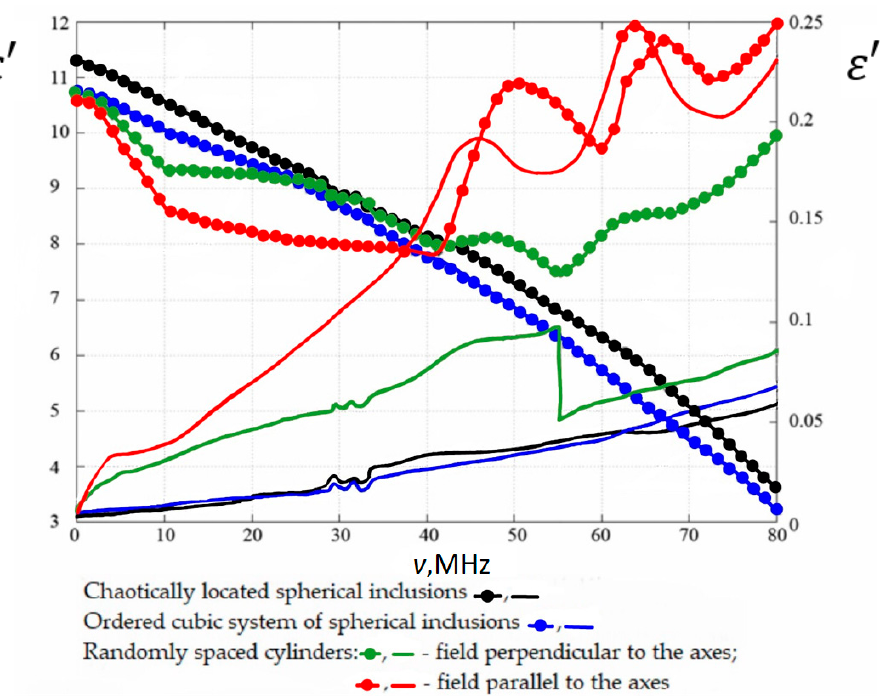
Figure 5. Frequency dependences of the complex permittivity for cylindrical and spherical SiO 2 inclusions in a matrix Si.